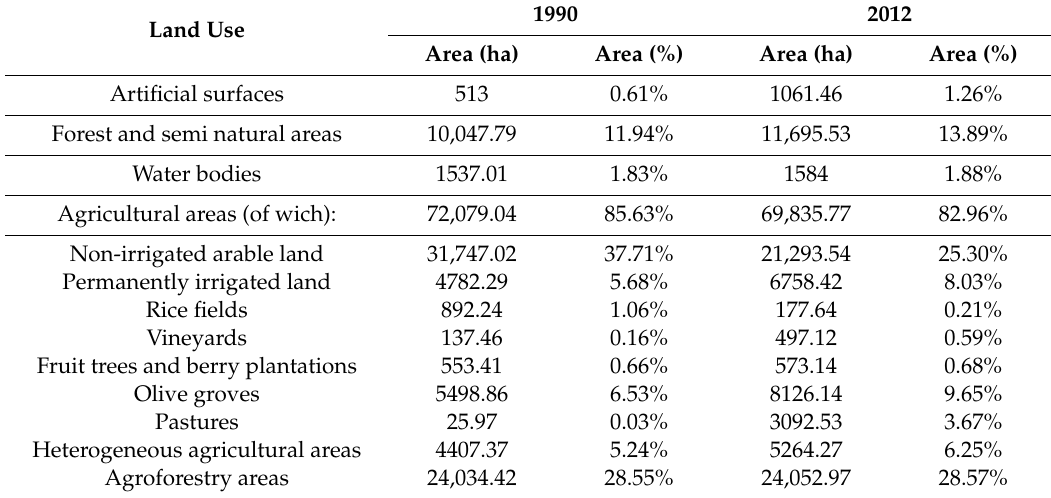
Table 1. Land use within Caia River basin and structure of agricultural land according to the coordination of information on the environment (CORINE) programme land cover project in 1990 and 2012.